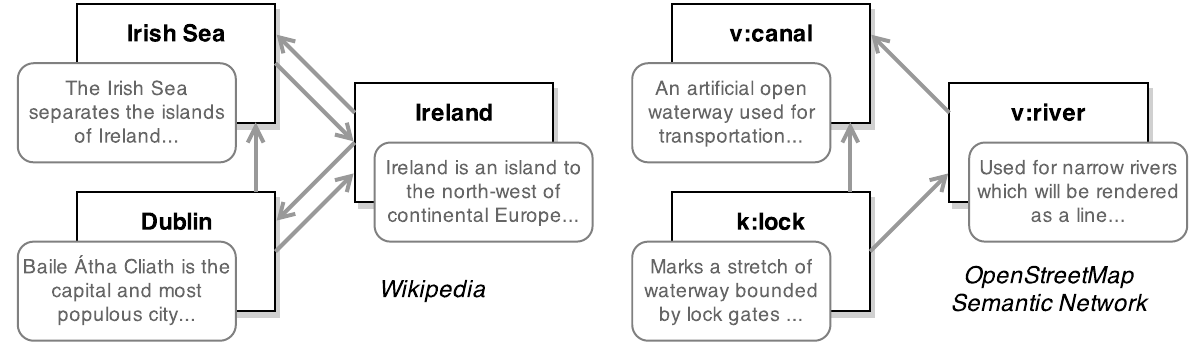
Figure 1. Fragments of geo-knowledge graphs (GKGs) extracted from Wikipedia and the OpenStreetMap